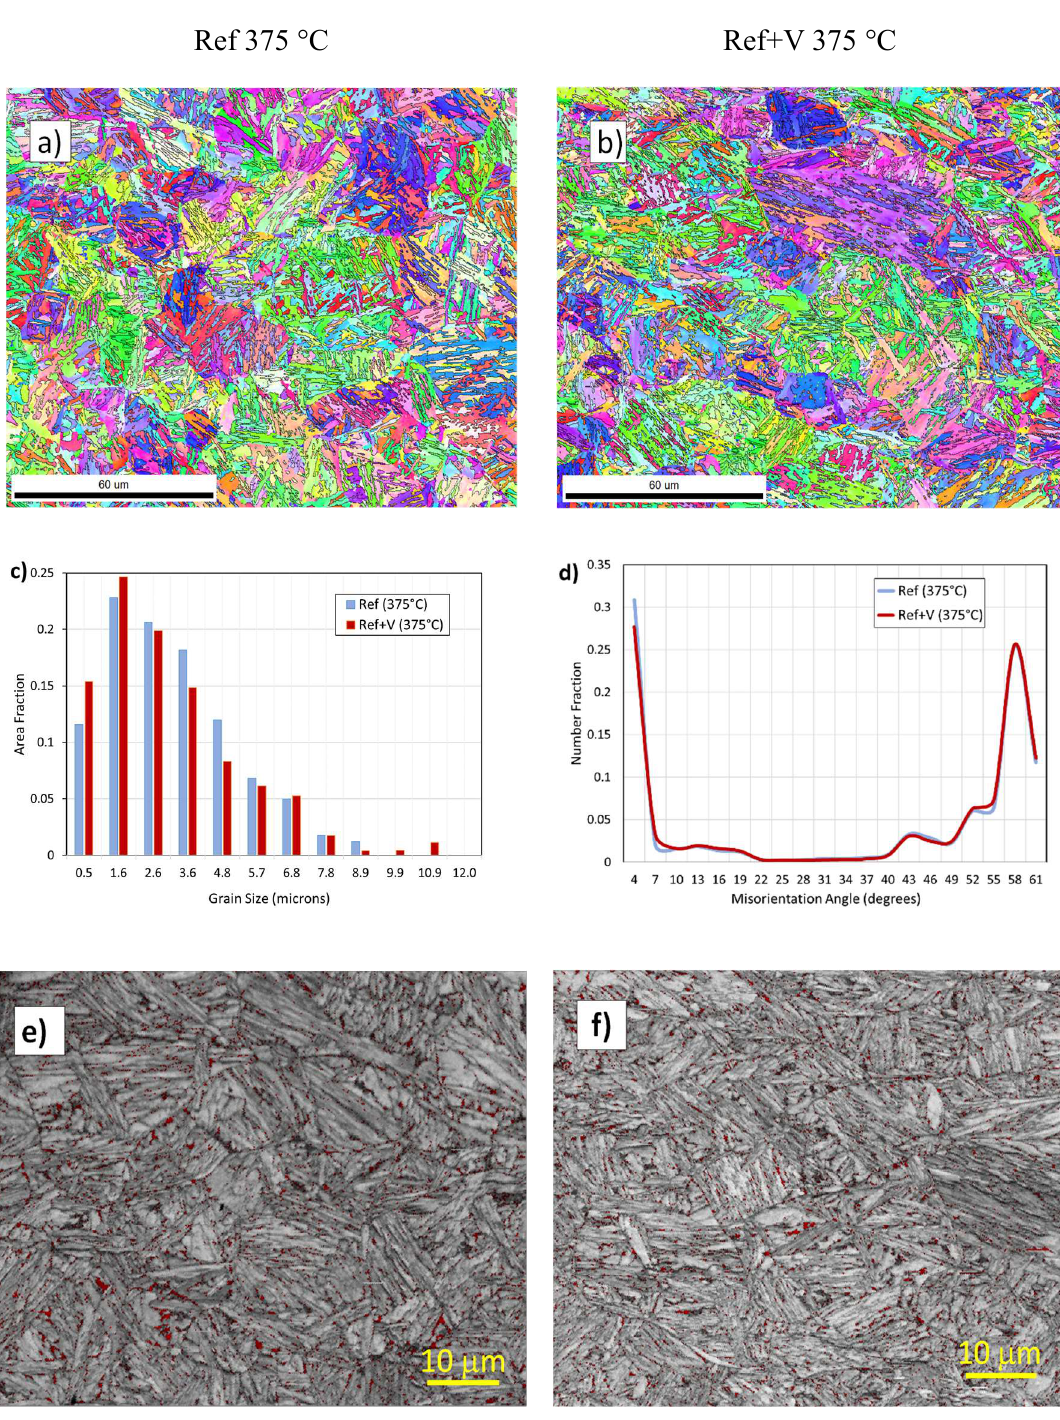
Figure 2. Electron back scattered di ff raction (EBSD) data from Ref and Ref + V alloys transformed at 375 ◦ C: ( a,b ) Euler orientation maps with high angle ( θ > 15 ◦ ) boundaries shown; ( c ) low angle ( θ < 5 ◦ ) boundary size distributions; ( d ) misorientation frequencies and ( e,f ) image quality maps with superimposed austenite islands in red. Table 3. Phase fractions from synchrotron high energy synchrotron X-ray diffraction (HEXRD), EBSD and optical microscopy data.